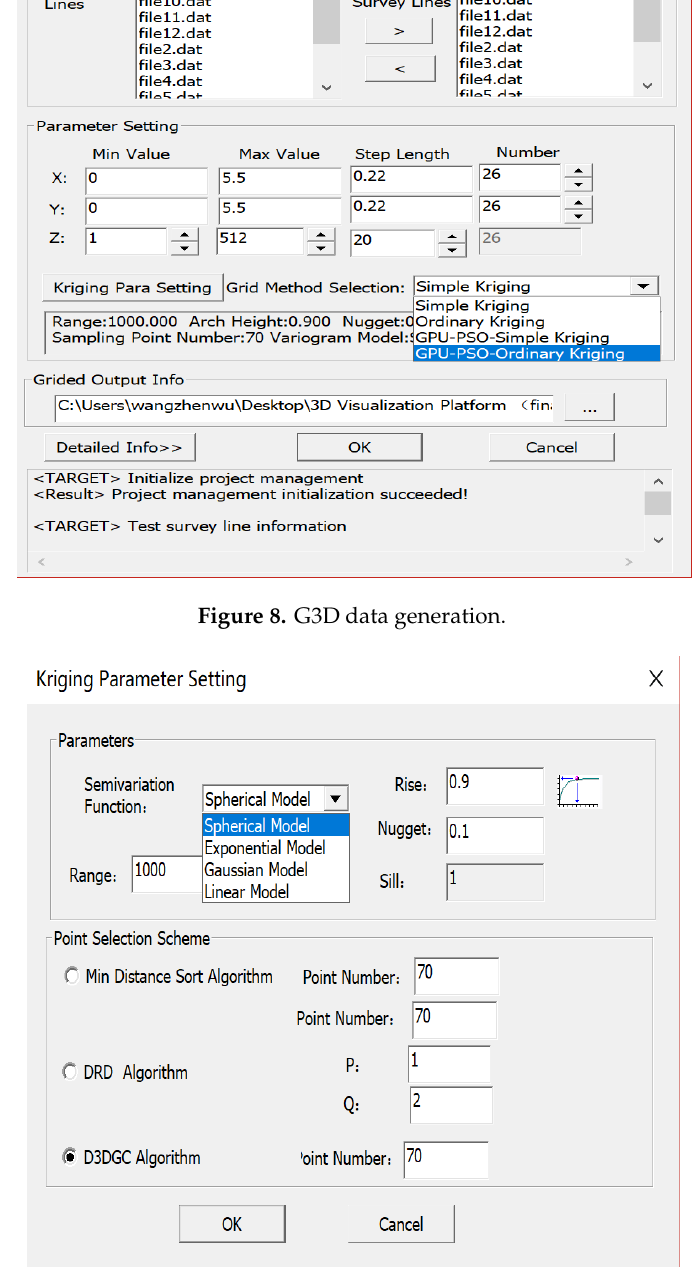
Figure 9. Parameters configuration.